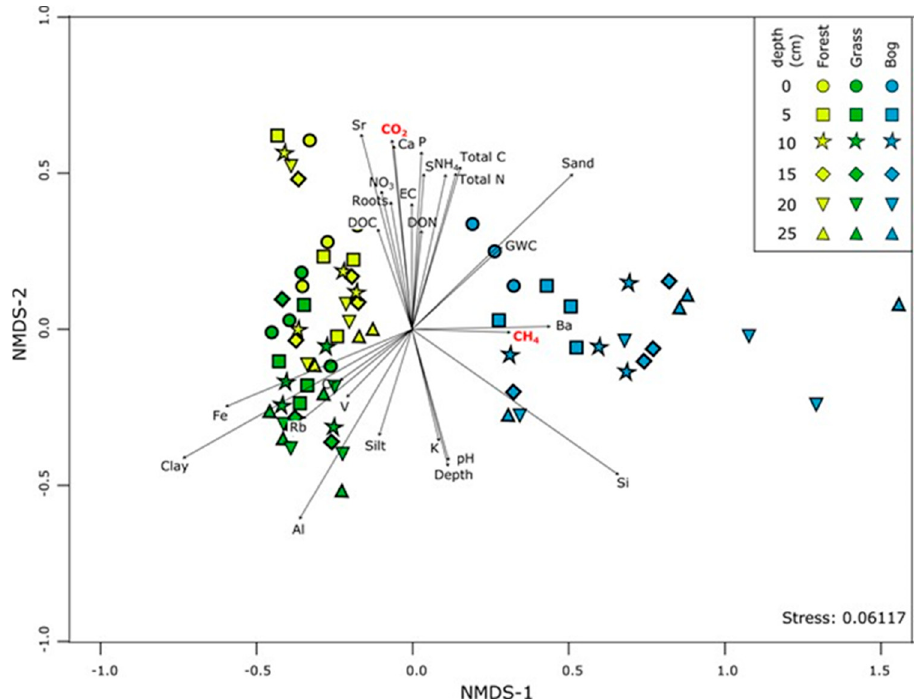
Figure 7. Nonmetric multidimensional scaling (NMDS) ordination of bacterial 16S rRNA communities based on the Bray–Curtis dissimilarity of community composition. Arrow vectors are environmental predictors (CO 2 , CH 4 , heavy elements, and other soil properties) that best fit onto the NMDS ordination space. Abbreviations: EC, electrical conductivity; DOC, dissolved organic carbon; DON, dissolved organic nitrogen; GWC, gravimetric water content; NO 3 , nitrate.